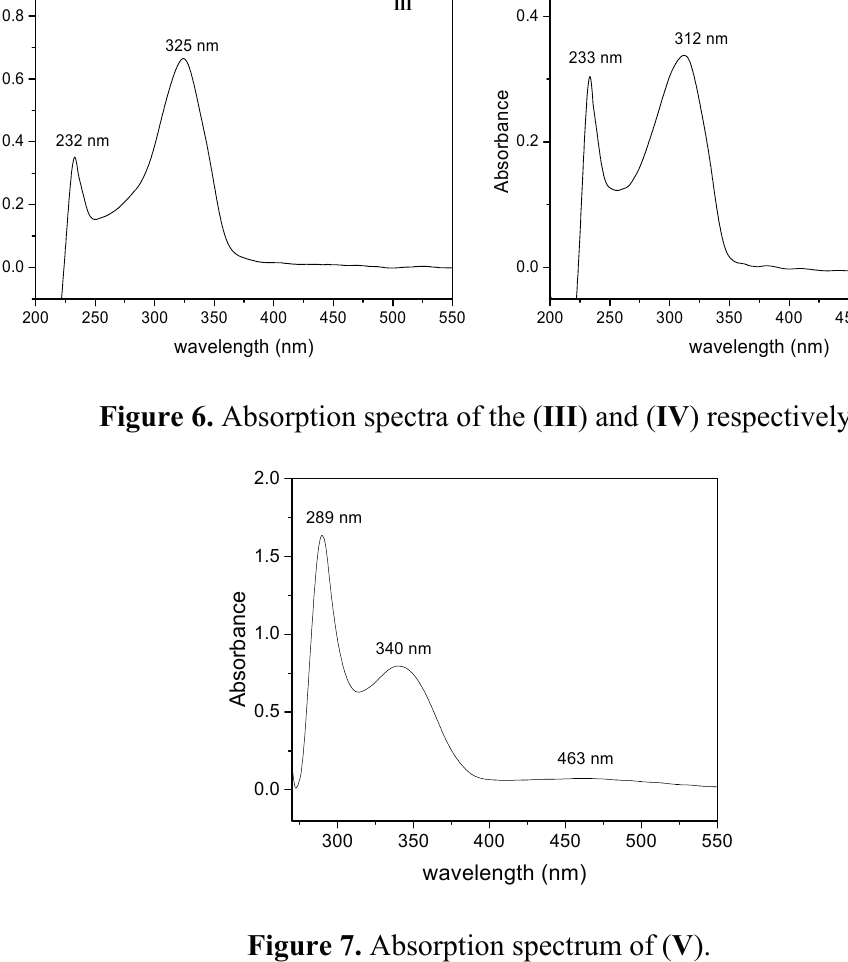
Figure 7. Absorption spectrum of ( V